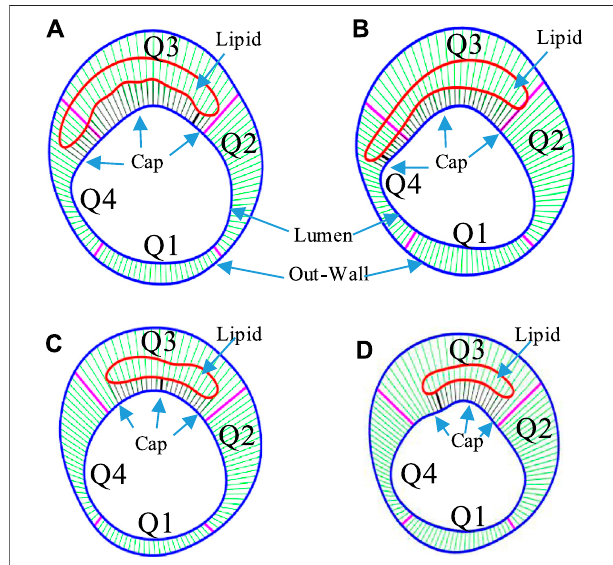
FIGURE 2 | The Four-Quarter Even-Spacing method with which cap thickness was de fi ned and calculated. Cap thickness differences between IVUS and IO slices and between baseline and follow-up are shown. (A) IVUS segmented contours with lumen – outwall connection lines at baseline. (B) Corresponding IVUS + OCT (IO) segmented contours with lumen – outwall connection lines at baseline. (C) IVUS slice with connection lines at follow-up. (D) Corresponding IVUS + OCT (IO) slice with connection lines at follow-up. Minimum cap thickness was marked using bold